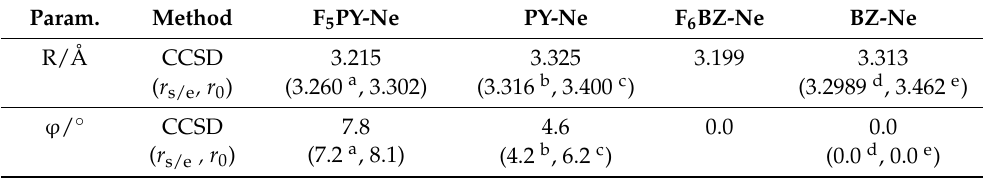
Table 4. Intermolecular distance between the center of mass of the aromatic system and the Neon atom (Å), R, and the deviation of the perpendicular axes ( ◦ ), ϕ . The values from experimental data sources are provided in parenthesis.